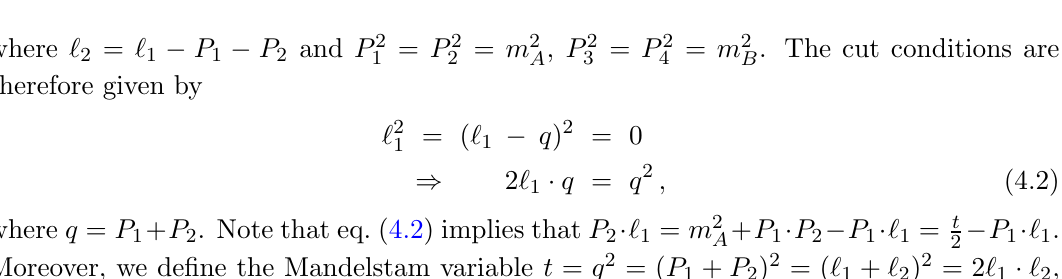
Figure 2 . Double Cut